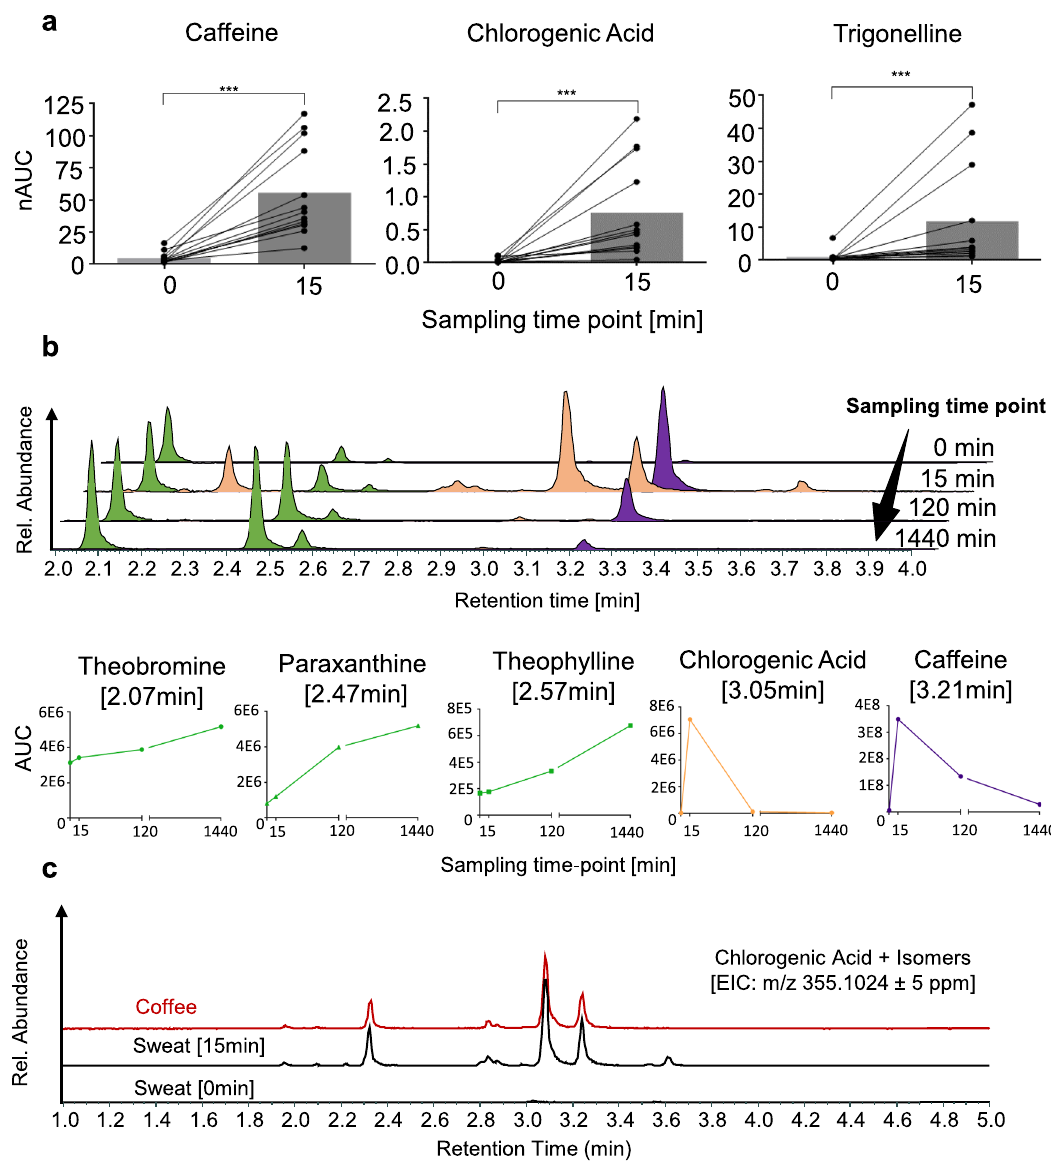
Fig. 3 Xenobiotics are detected in a time-dependent manner in sweat from the fi ngertips after coffee consumption. a Levels of normalised areas under the curve (nAUCs) for caffeine, chlorogenic acid and trigonelline, before (0) and 15 min (15) after coffee consumption are shown, demonstrating a signi fi cant increase in all participants ( n = 13 × 2 time-points) after 15 min. D ’ Agostino & Pearson test was performed to check normality of the data. Paired two-tailed Wilcoxon signed rank tests were performed for 13 volunteer pro fi les, delivering a p -value = 0.0002 for caffeine, chlorogenic acid and trigonelline. The mean nAUCs (boxes) and standard deviations are the following: for caffeine 4.8 ± 4.4 at 0 min and 56 ± 35 at 15 min, for chlorogenic acid 0.03 ± 0.04 at 0 min and 0.8 ± 0.7 at 15 min, for trigonelline 1.0 ± 1.7 at 0 min and 12 ± 16 at 15 min. b The temporal evolution of metabolite pro fi les is exemplarily shown for one participant (Volunteer 3, study A). The sampling time-point 1440 min represents the time-point before consumption on the second sampling day. Whereas caffeine (violet) and chlorogenic acid AUCs (orange) were found to increase quickly after coffee consumption followed by rapid clearance, the levels of theobromine, paraxanthine and theophylline (green) increased more slowly within the observation period. c Similarity of extracted ion chromatograms (EIC) of chlorogenic acid and its isomers from coffee extracts and from sweat of the fi ngertips 15 min after coffee consumption. The corresponding sample collected just before coffee consumption (0 min) served as negative